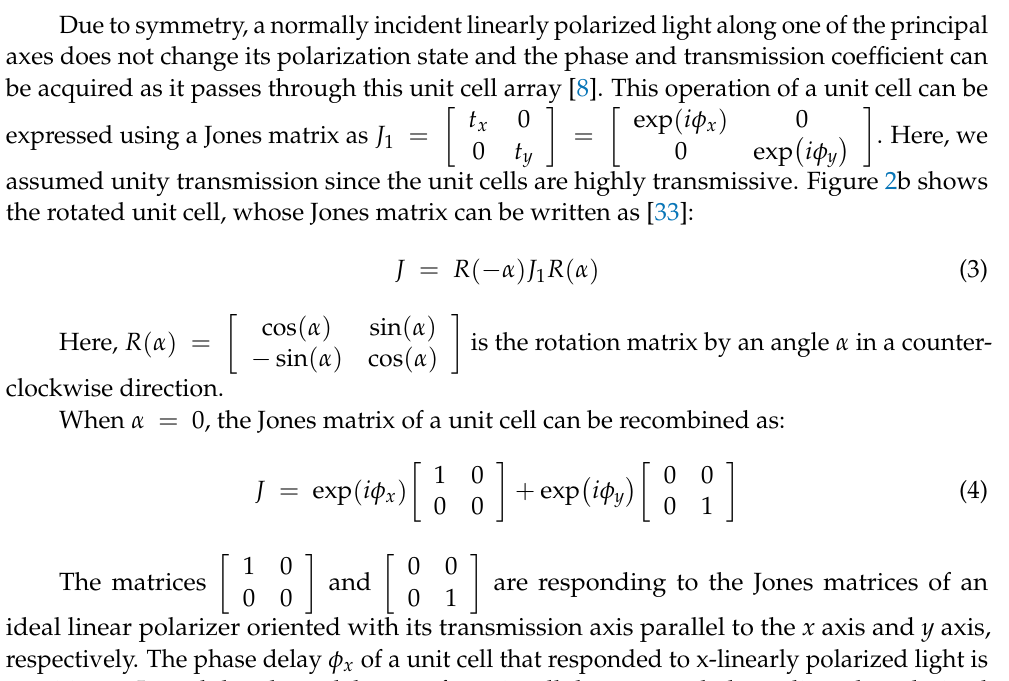
Figure 2. ( a ) A unit cell with a rectangular TiO 2 nanostructure resting on SiO 2 . ( b ) A rotated unit cell.